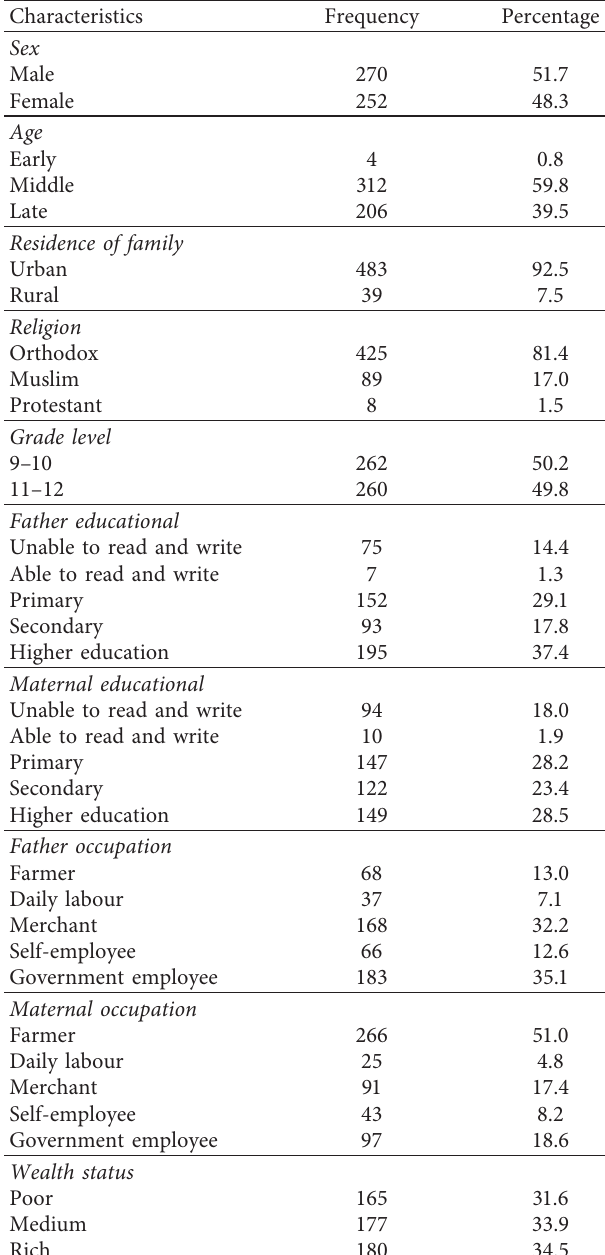
Table 1: Sociodemographic characteristics of school adolescents and their parents at Bahir Dar city high school ( n �